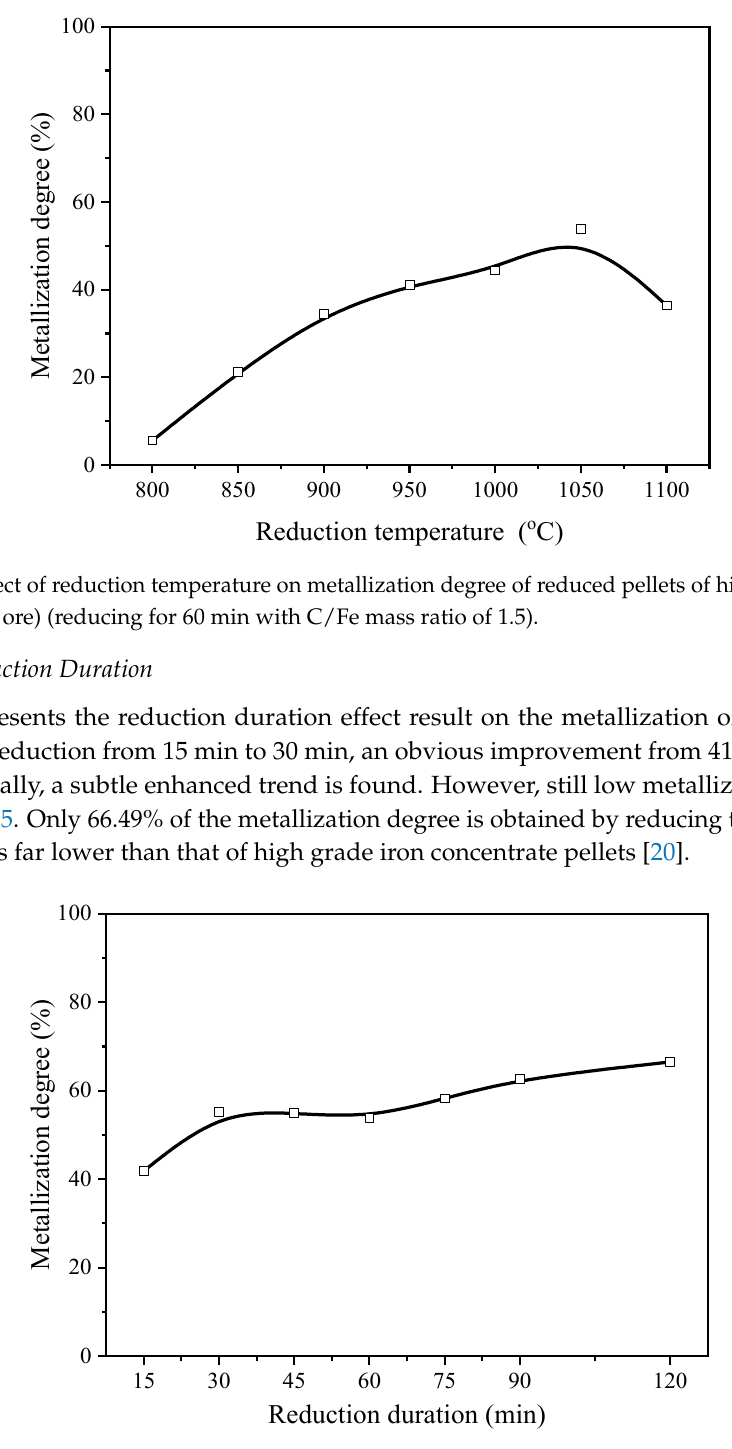
5 of 12 Figure 3. Schematic of vertical furnace for reduction. 3. Results 3.1. Effect of Reduction Temperature The single HA ore pellets were reduced by optimizing the reduction parameters, to reveal the